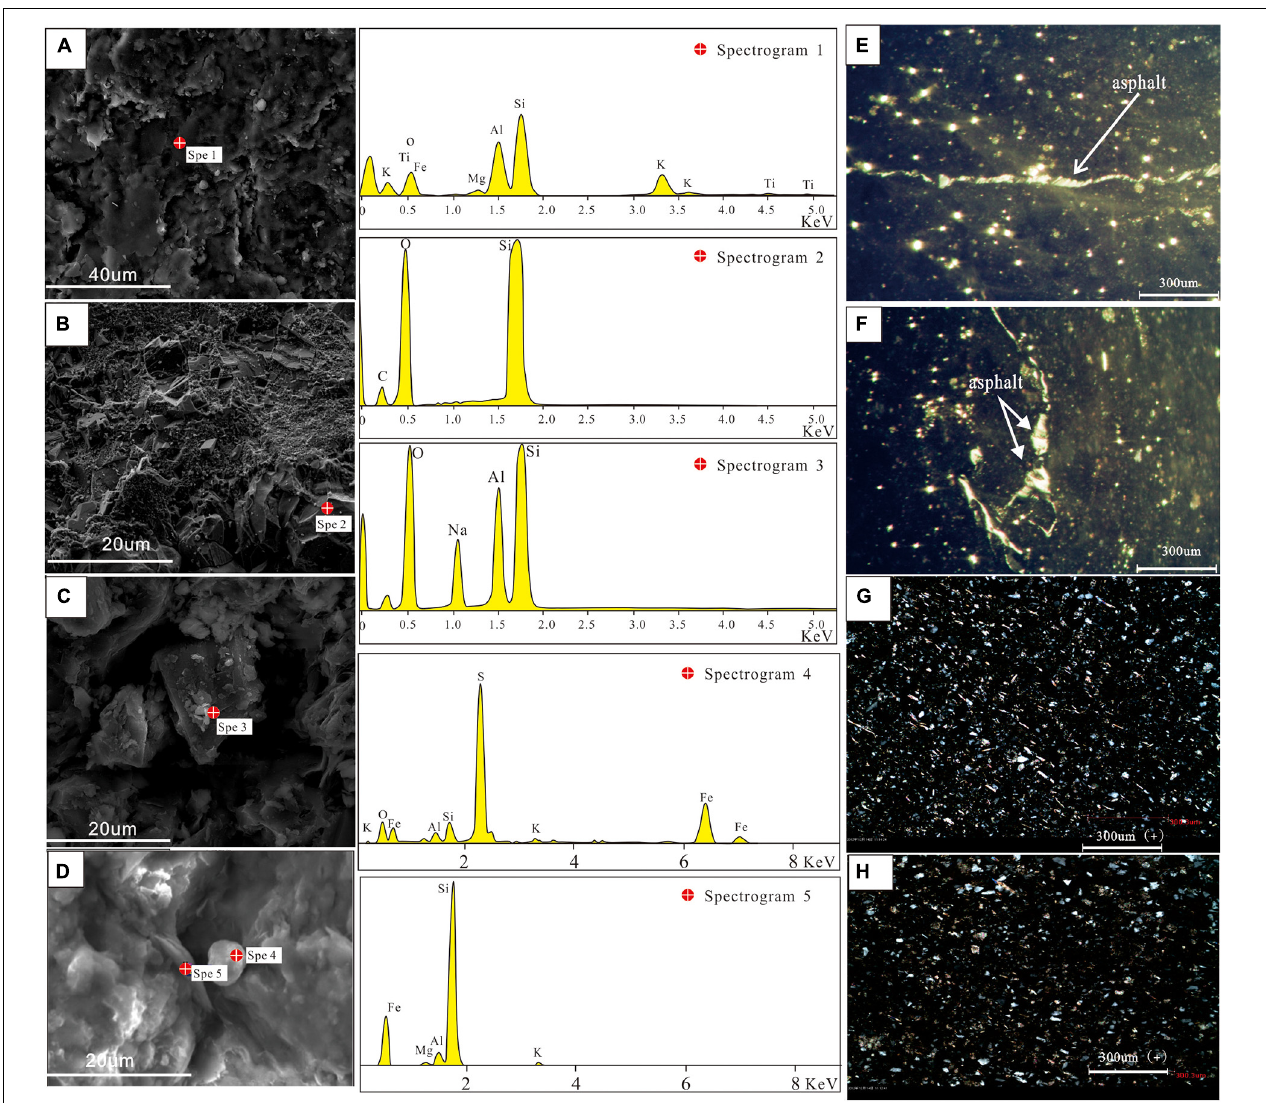
FIGURE 7 | Microscopic minerals and diagenetic characteristics of the Longmaxi Formation shale in the Sichuan Basin margin [scanning electron microscope (SEM) and energy-dispersive spectroscopy (EDS)]. (A) An SEM image showing the clay minerals; the right image of (A) is the corresponding EDS (spectrogram 1), the Shizhu section, layer 2. (B) An SEM image showing authigenic quartz; the right image is the corresponding EDS (spectrogram 2), the Shizhu section, layer 8. (C) An SEM image showing clay minerals grow on the surface of authigenic quartz; the right image is the corresponding EDS (spectrogram 3), the Shizhu section, layer 11. (D) An SEM image showing illite and pyrit; the right image is the corresponding EDS (spectrograms 4 and 5), the Shizhu section, layer 11. (E) A fluorescence microscope image showing asphalt in micro-cracks, well QQ-1, 756.13 m. (F) A fluorescence microscope image showing asphalt in micro-cracks, well QQ-1, 765.52 m. (G) Micrographs of thin sections (MTS) showing the quartz in shale, well YQ-1, 1,126.44 m. (H) Micrographs of thin sections (MTS) showing the quartz in shale, well YQ-1, 1,130.38